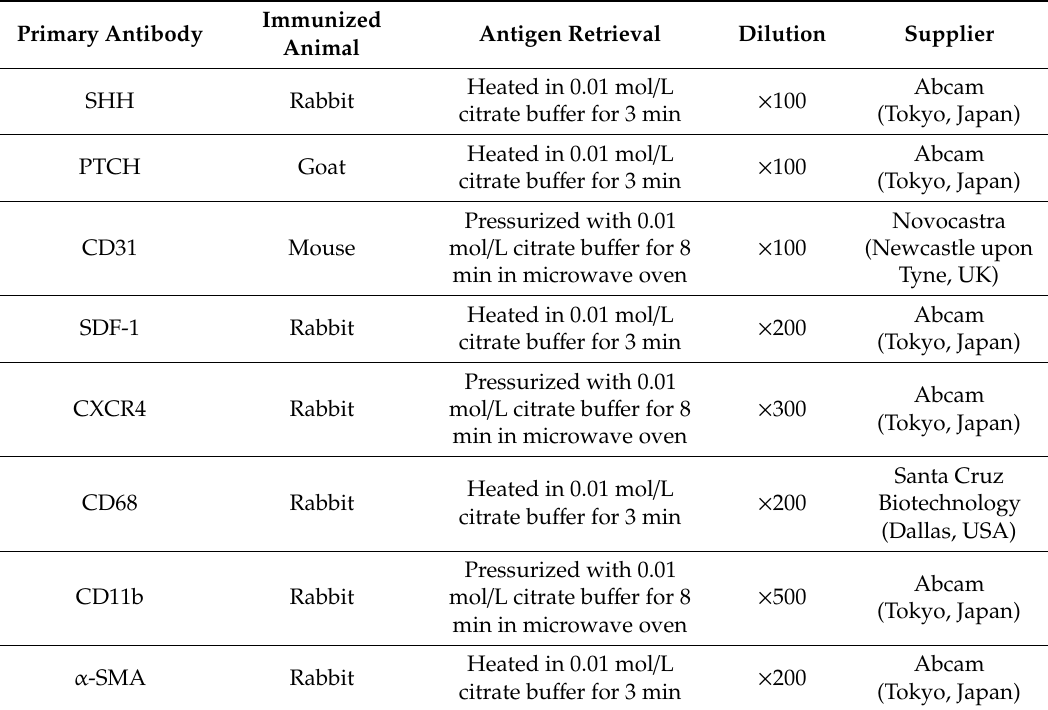
Table 1. Antibodies used in